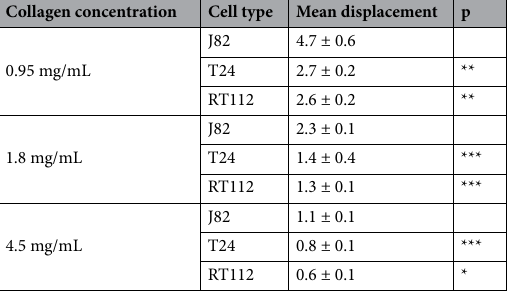
Table 2. Mean values of the largest fiber displacements (in μm) ± standard error of the mean. Statistical significance p (in comparison to J82 cells) for each collagen concentration is also indicated: *p < 0.05, **p < 0.01, and ***p <